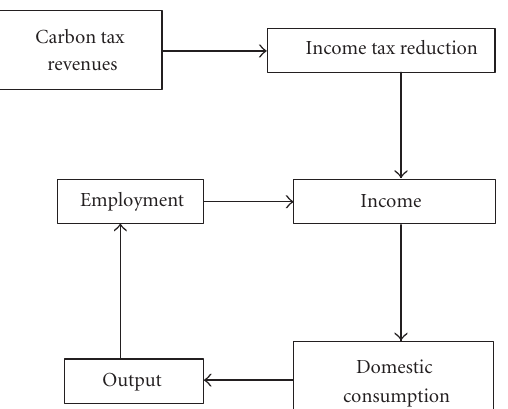
Figure 3: Potential e ff ects of revenue